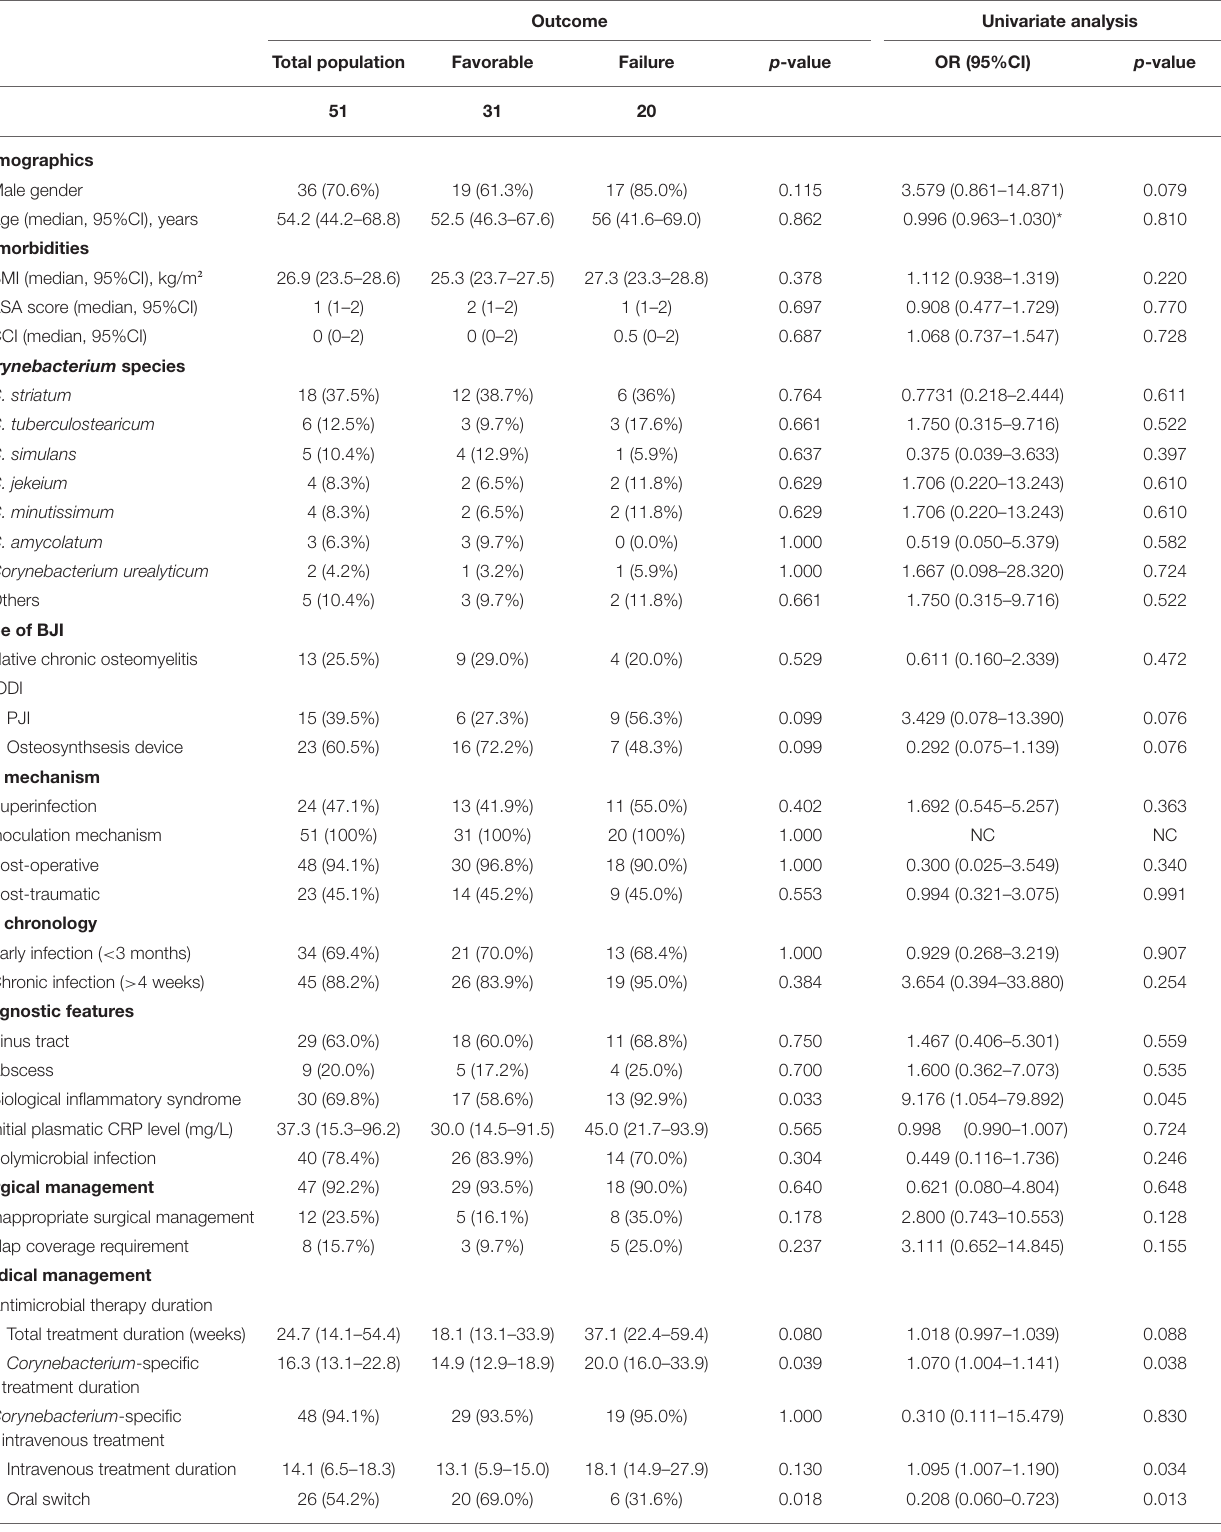
TABLE 1 | Comparison of patients with favorable and unfavorable outcome and determinants of treatment failure in all patients with Corynebacterium spp. BJI (univariate